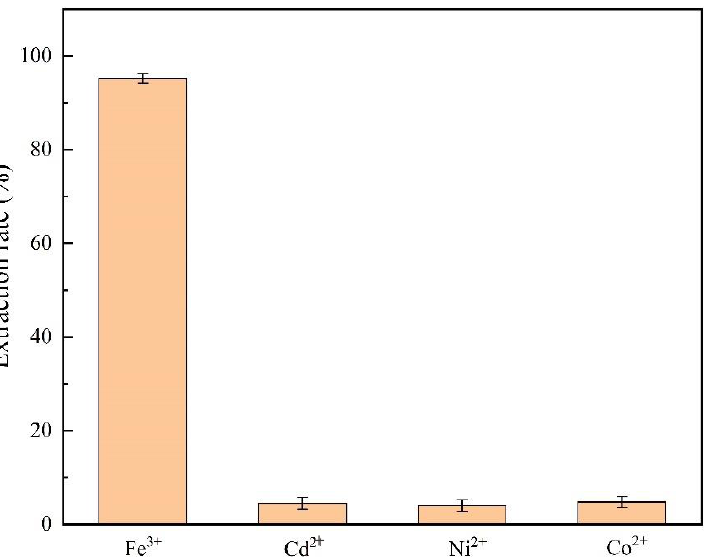
Figure 1. Saponified D2EHPA metal ion extraction rate from synthetic leachate under the conditions: room temperature (298 K), [D2EHPA] = 1 mol/L, initial [Fe 3+ ] = 12.25 g/L, extraction time = 20 min, saponification rate = 70%, initial pH = 1.00, and phase ratio = 1:1.